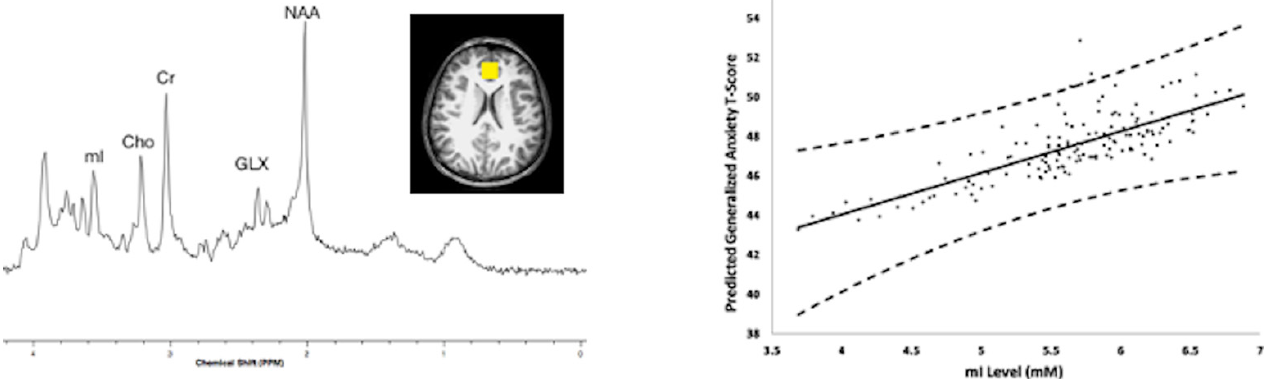
Figure 7. Magnetic resonance spectroscopy was acquired using a 3 Tesla scanner from the Cincinnati Childhood Allergy and Air Pollution Study (CCAAPS) cohort at age 12 years. Left, representative short echo spectrum from a CCAAPS participant with notations for neurochemicals, N-acetylaspartate (NAA), Glutamate and glutamine (GLX), creatine and phosphocreatine (Cr), cholines (Cho), myo-inositol (mI) and an insert of a representative voxel location shown in yellow within the perigenual anterior cingulate cortex for the 8 cubic centimeter (2 cm per side) positioned on an axial T1-weighted image. Higher myo-inositol concentrations were observed for participants with higher estimated element carbon attributable to traffic (ECAT) in the previous year of life. Right, the relationship between myo-inositol concentration and child reported generalized anxiety T-scores obtained from a generalized anxiety subscale of the Spence Children’s Anxiety Scale (SCAS) and adjusted for covariates at age 12 years.